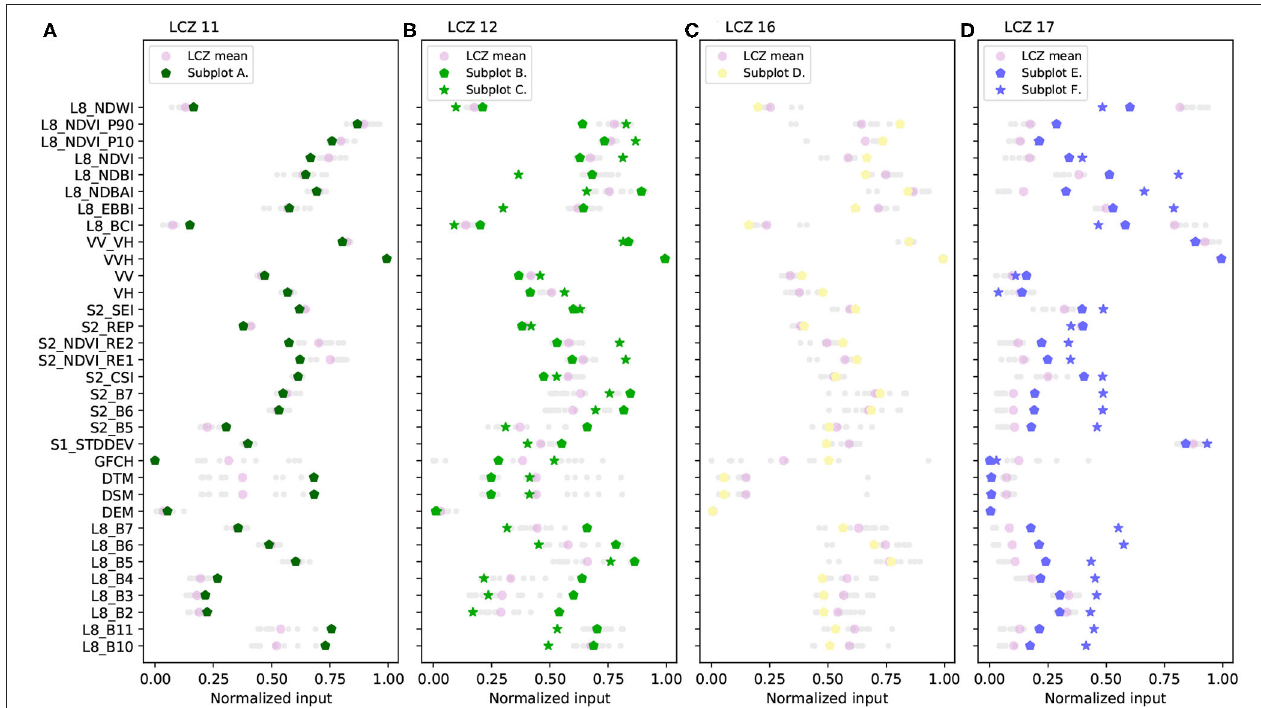
FIGURE 9 | Normalized polygon-averaged spectral input values (gray dots), for all LCZ classes shown in Figure 8 , for Bamako. Pink circles denote the mean over all polygons, other markers in corresponding LCZ colors refer to the polygons shown in Figure 8